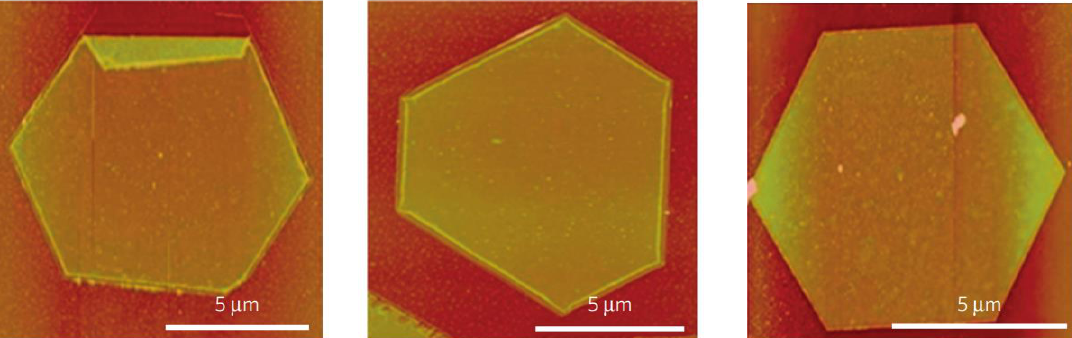
Figure 7. AFM images of the hexagonal ultrathin α -Mo2C crystals are synthesized using direct synthesis via the CVD method using carbon source from methane and a layered Cu/Mo foil as the substrate [71].